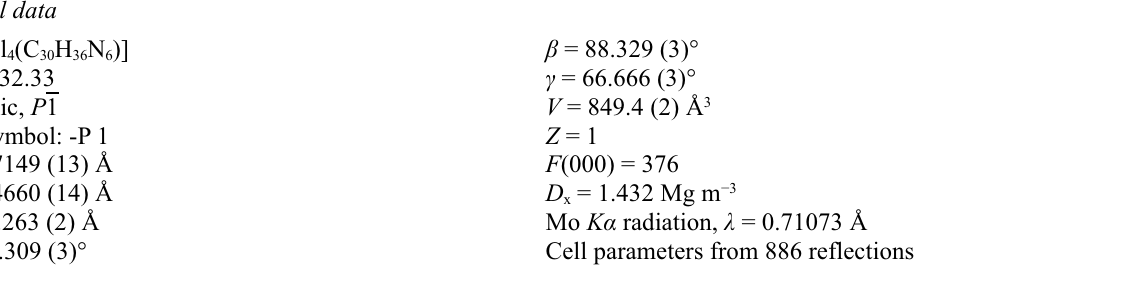
sup-2 Acta Cryst. (2009). E 65 , m249